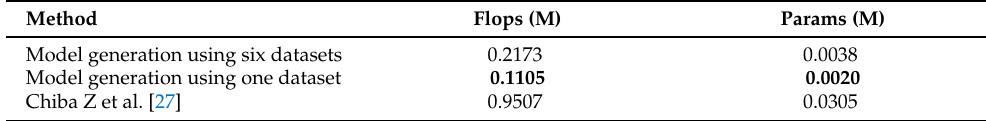
Table 12. Average complexity of different